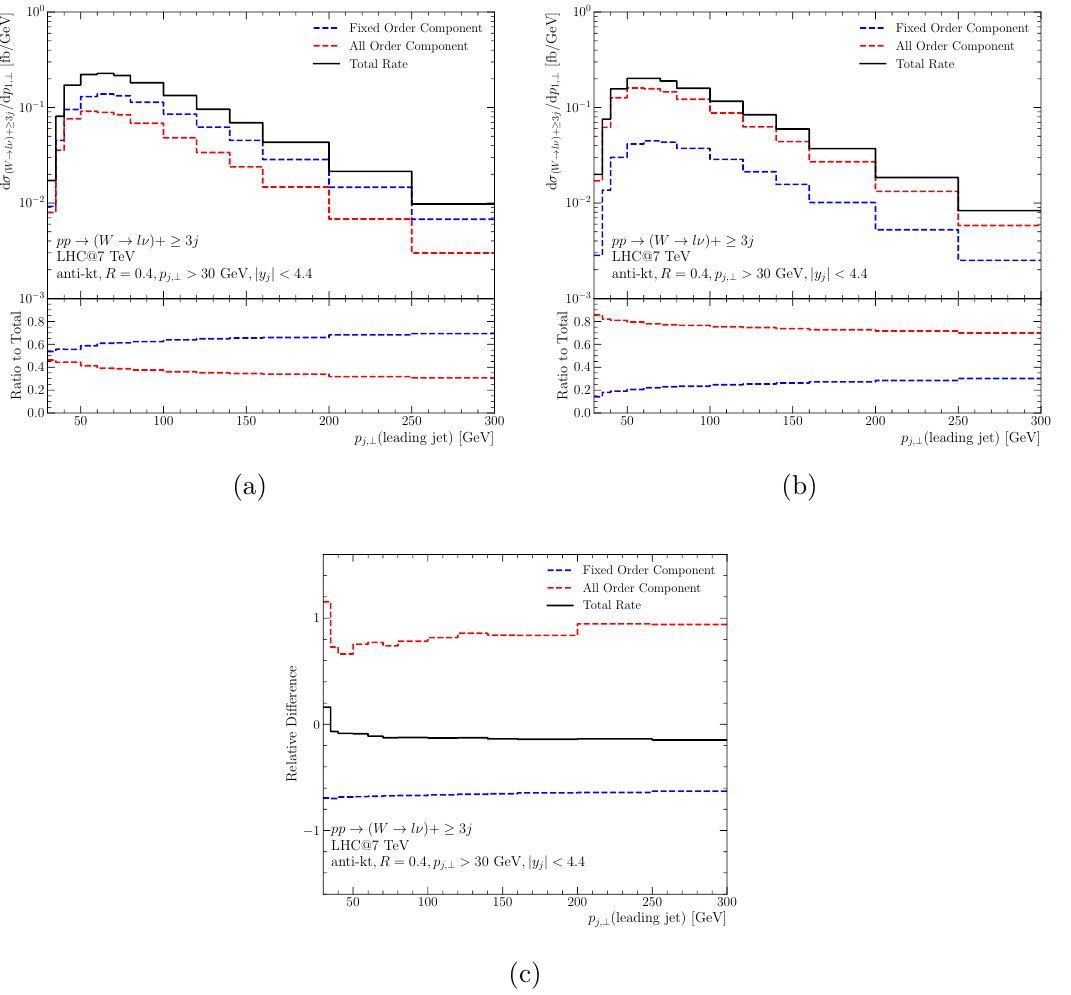
Figure 13. The differential distribution (black, solid) in the transverse momentum of the leading jet in pp → ( W → ‘ν )+ ≥ 3 j , without and with resummation applied to NLL states. The panels and lines are as in figure